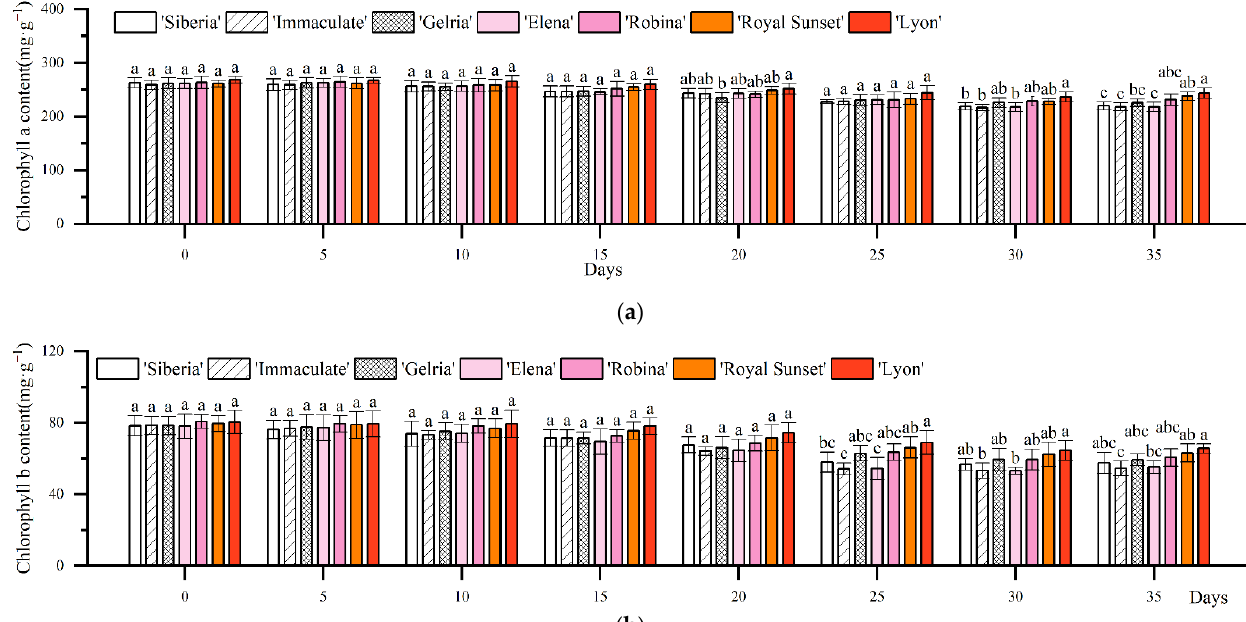
Figure 4. Effects of drought stress on chlorophyll content of lily leaves: ( a ) Effects of drought stress on chlorophyll a content; ( b ) Effects of drought stress on chlorophyll b content. Different letters above bar graphs indicate significant difference among lily varieties ( p < 0.05, n = 3).